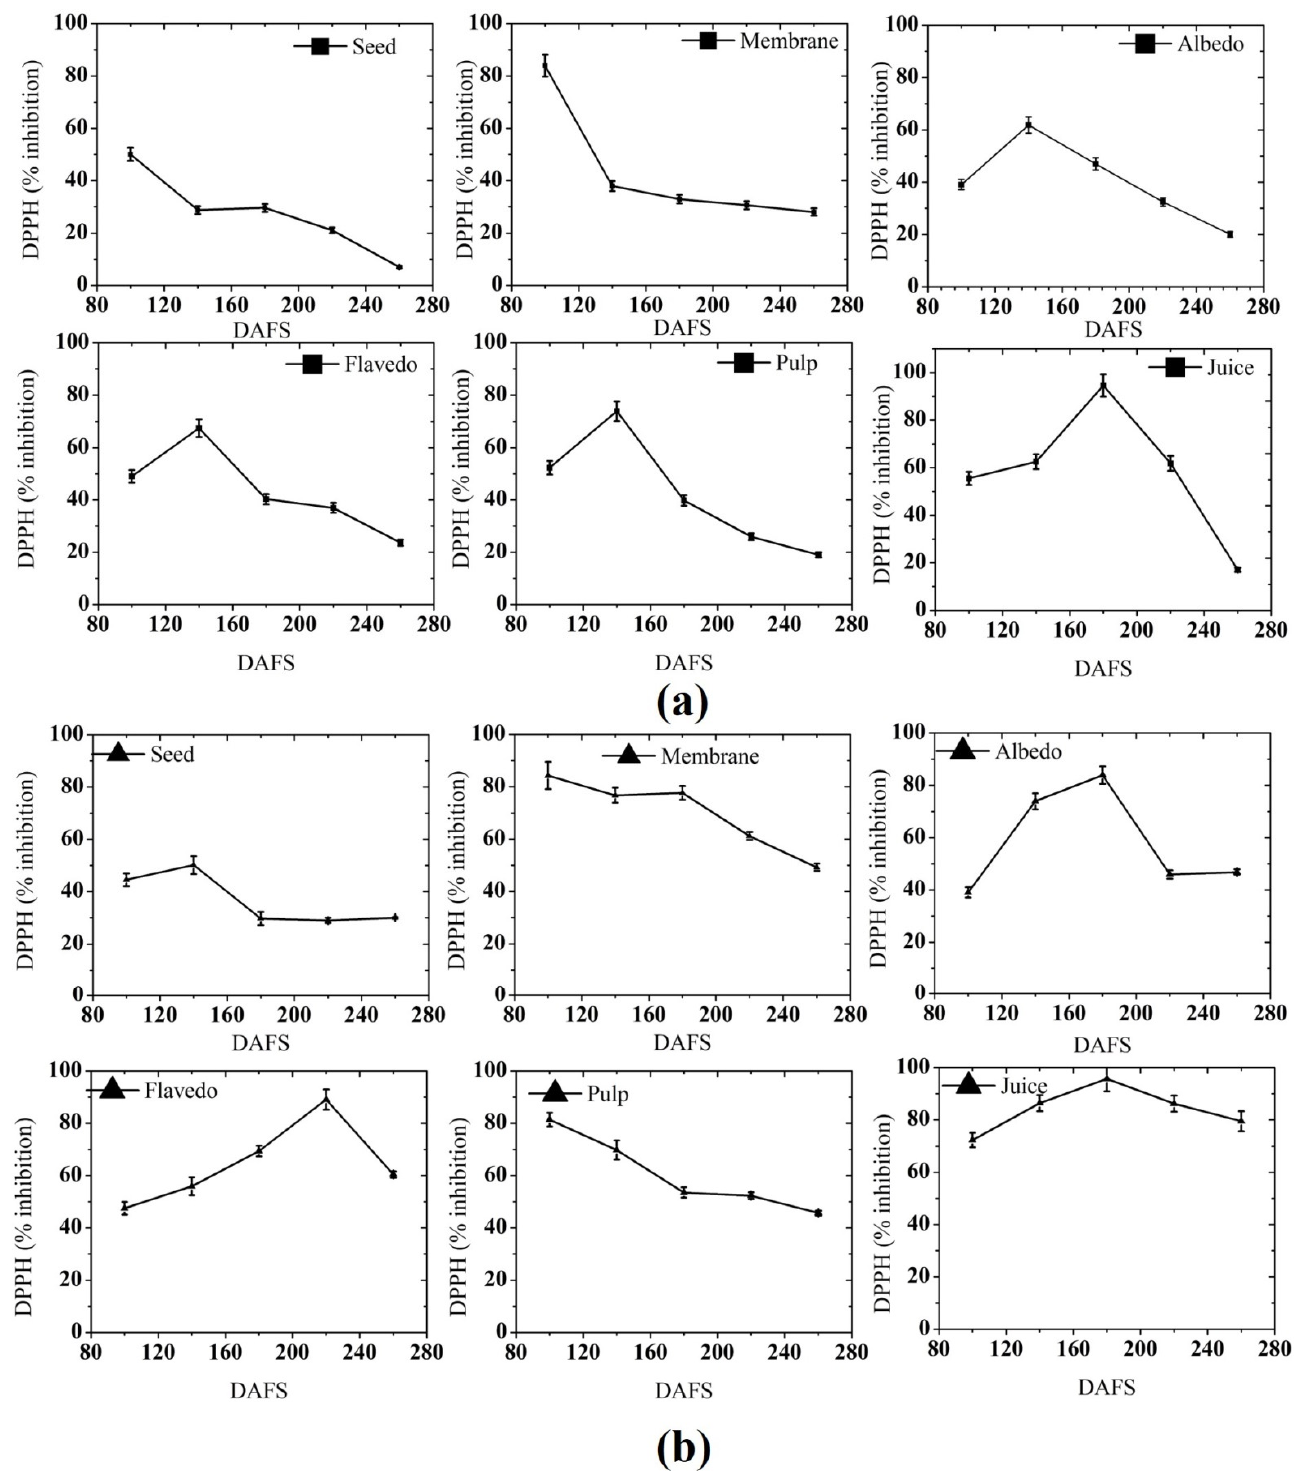
Figure 9. DPPH free radical scavenging activity in ( a ) 2018; and ( b ) 2019. DAFS: days after fruit set.